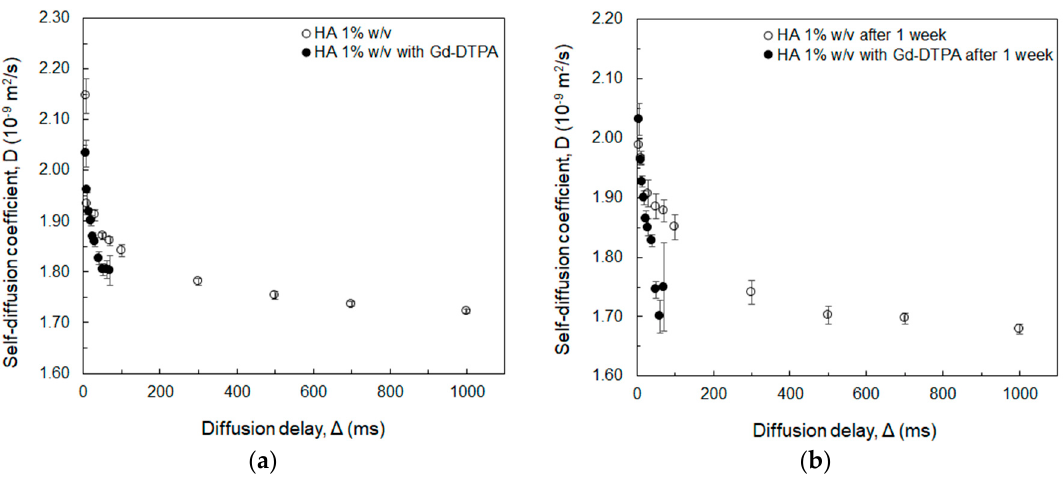
Figure 4. NMR-DOSY measurements of water self-diffusion coefficient at 600 MHz as a function of the diffusion delay in: ( a ) 1% w / v HA with and without Gd-DTPA at 18 mM; ( b ) measurements repeated after one week.